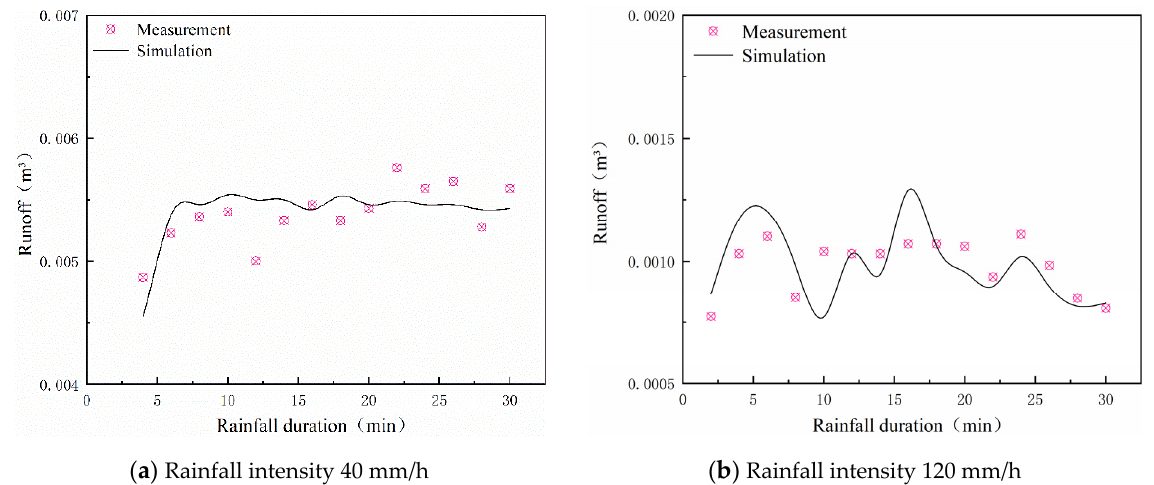
Figure 13. Comparison between measured and simulated runoff rates under different rainfall intensities (loess test steel trough is 3 m).